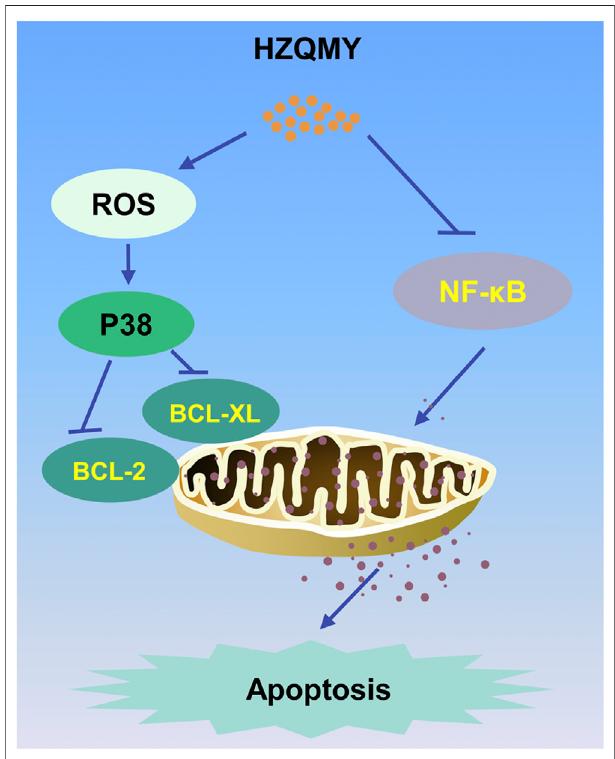
FIGURE 8 | The mechanism of the inhibitory effect of HZQMY in HRCECs. HZQMY regulated ROS/P38 signaling pathway, and then inhibited the expression of BCL-2 and BCL-XL. What ’ s more, HZQMY also inhibited NF- κ B signaling pathway to induce mitochondrial apoptosis.